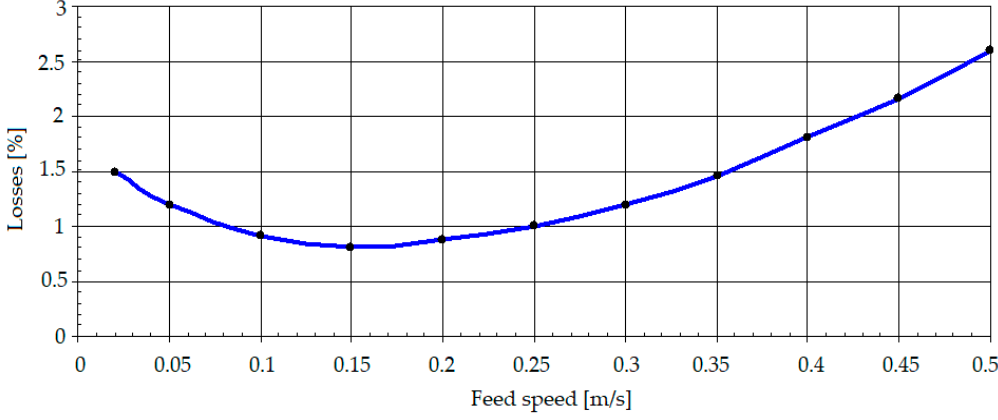
Figure 9. The variation in losses ( p ) depending on the feed speed ( v a ) .